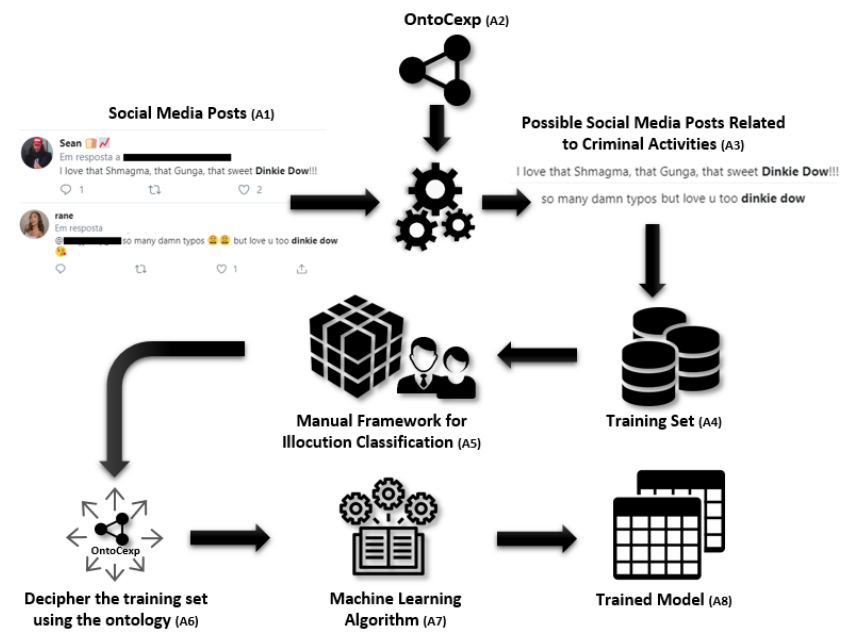
Figure 3. Machine learning training model in the the